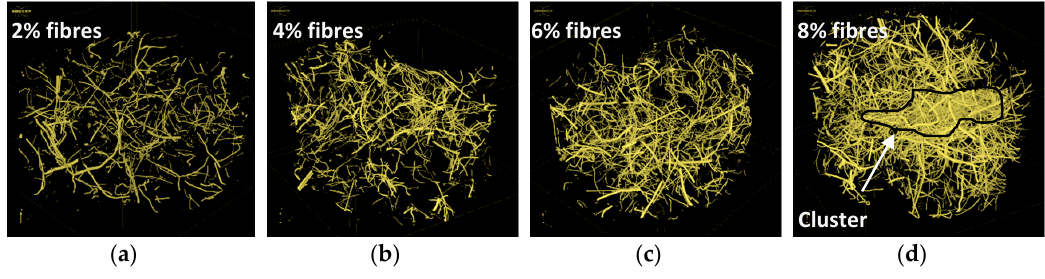
Figure 5. CT-scan 3D reconstructions of fibre spatial distribution inside asphalt mixture samples with different fibre contents: ( a ) 2%; ( b ) 4%; ( c ) 6%; ( d ) 8% of steel wool fibres. Bounding box dimensions are 25 × 25 × 12 mm, approximately.